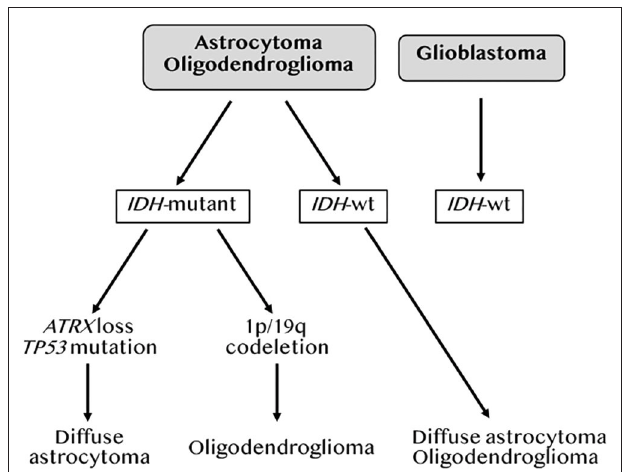
FIGURE 2 | Molecular classification of gliomas. Adapted from the 2016 WHO classification of brain tumors by DeWitt JC et al. ( 26).